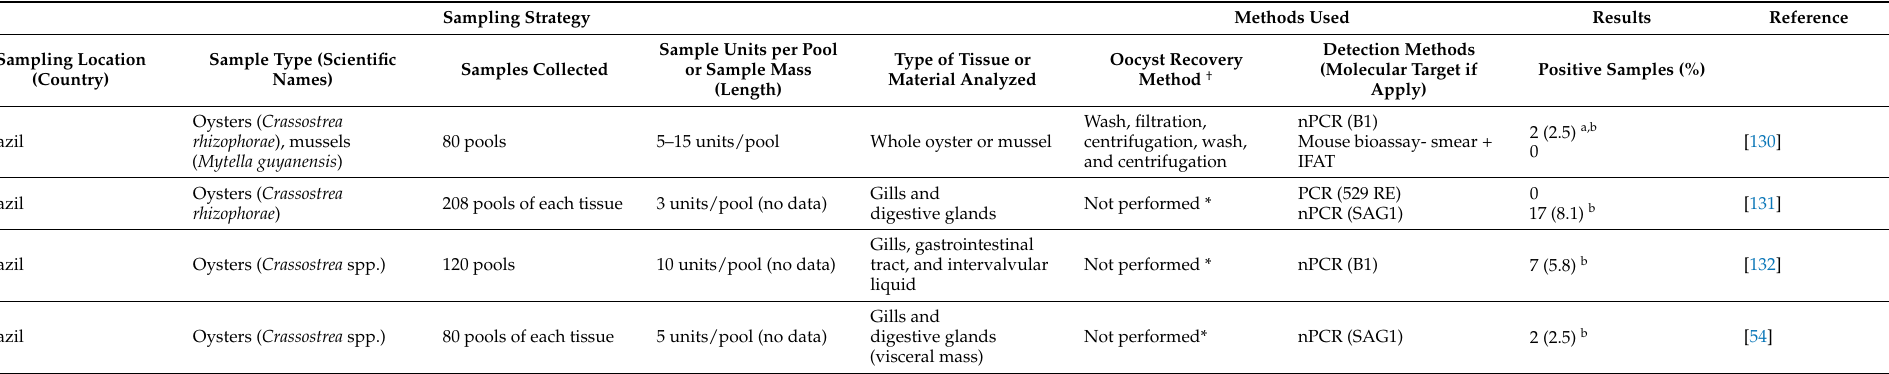
Table 4. Worldwide detection of Toxoplasma gondii oocysts in bivalve mollusks based on molecular and bioassay methods in articles published up to the end of